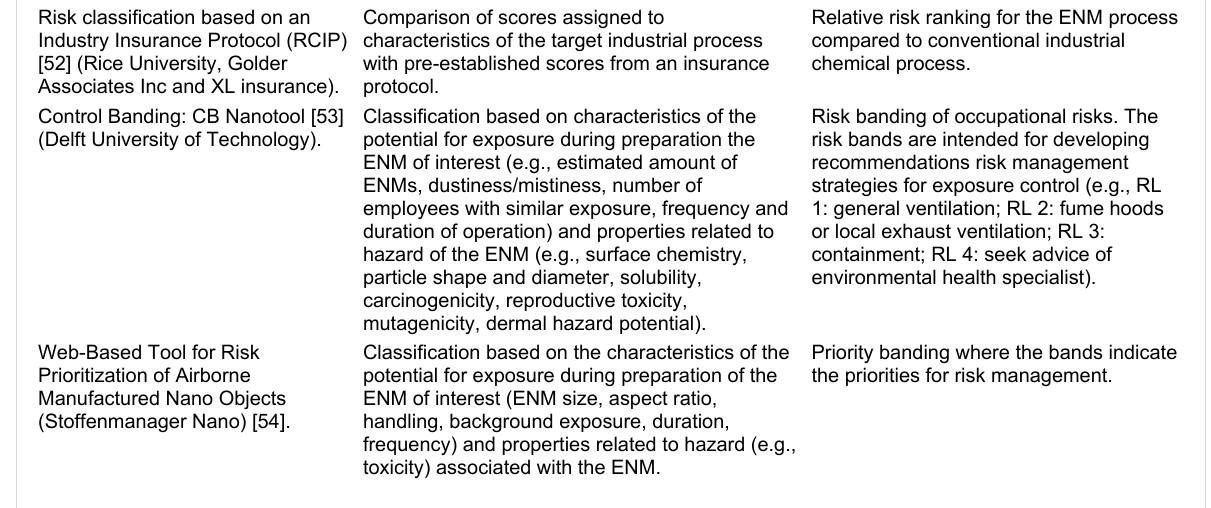
Table 1: Summary of critical characteristics of existing risk assessment frameworks relevant to ENMs. (continued) Risk classification based on an Industry Insurance Protocol (RCIP) [52] (Rice University, Golder Associates Inc and XL